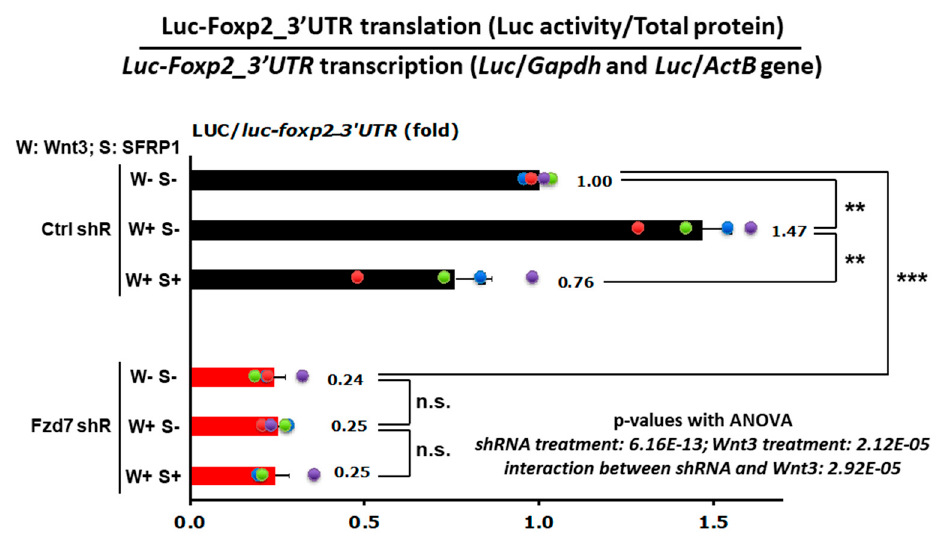
Figure 7. Translational reduction through Foxp2–3 ′ UTR with Fzd7 shRNA. Quantification of translational effects (protein/mRNA ratio) was carried out using Luciferase - Foxp2 _ 3 ′ UTR construct in neuronal N2a cells, transfected with the Ctrl or Fzd7 shRNA plasmid and treated with mock (W–S–), Wnt3 (100 ng/mL) (W+S–), or Wnt3 + SFRP1 (100 ng/mL) (W+S+) for 48 h ( n = 4 repeats). Translation was measured with Relative Luciferase light units (RLUs), and was then normalized to the Luciferase mRNA level (qRT-PCR). Data represent the mean and SEM. Statistics: Student’s t -test; **: p < 0.01; ***: p < 0.005; n.s.: not significant. Two-way ANOVA analysis with replication represents that the Fzd7 shRNA and Wnt3 treatments are significant and that the effects of them are dependent on each factor.